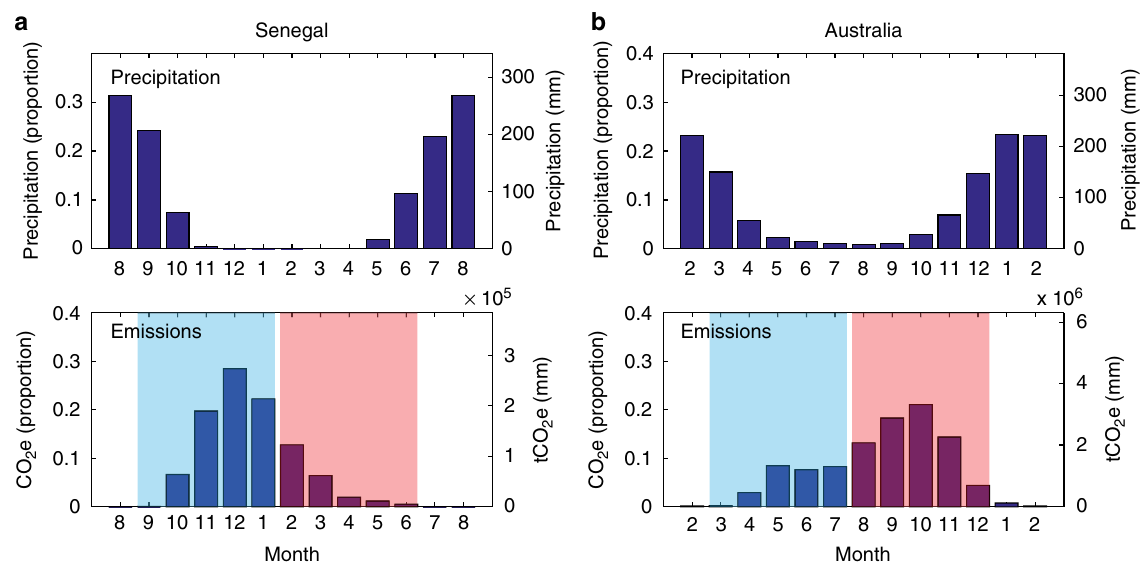
Fig. 3 Representative example of early dry season versus late dry season patterns of savanna burning. Senegal ( a ) is an example of a low intensity burning country, where the bulk of emissions are produced from low intensity fi res prior to the driest month. Australia ( b ) is an example of a high intensity burning country where the bulk of emissions are produced from high intensity fi res during, or following, the driest month. For this study, early dry season (EDS) emissions are calculated using the 5 months prior to the driest month (shaded in blue) and late dry season (LDS) emissions are calculated using the 5 months following the driest month, inclusive of the driest month (shaded in red). The driest month was de fi ned using long term (1981 – 2010) monthly mean precipitation. For display purposes, precipitation data are centered on the driest month for both Senegal (March) ( a ) and Australia (August) ( b ). Monthly mean emissions (2000 – 2014) of the combined N 2 O and CH 4 components of savanna burning are represented in tCO 2- e and are also